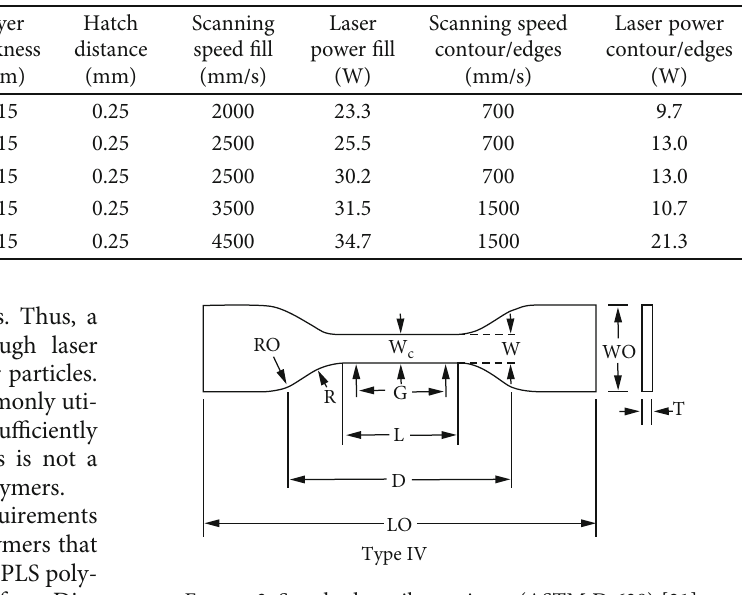
Figure 3: Standard tensile specimen (ASTM D 638) [21]. Table 4: The standard tensile specimen dimensions (ASTM